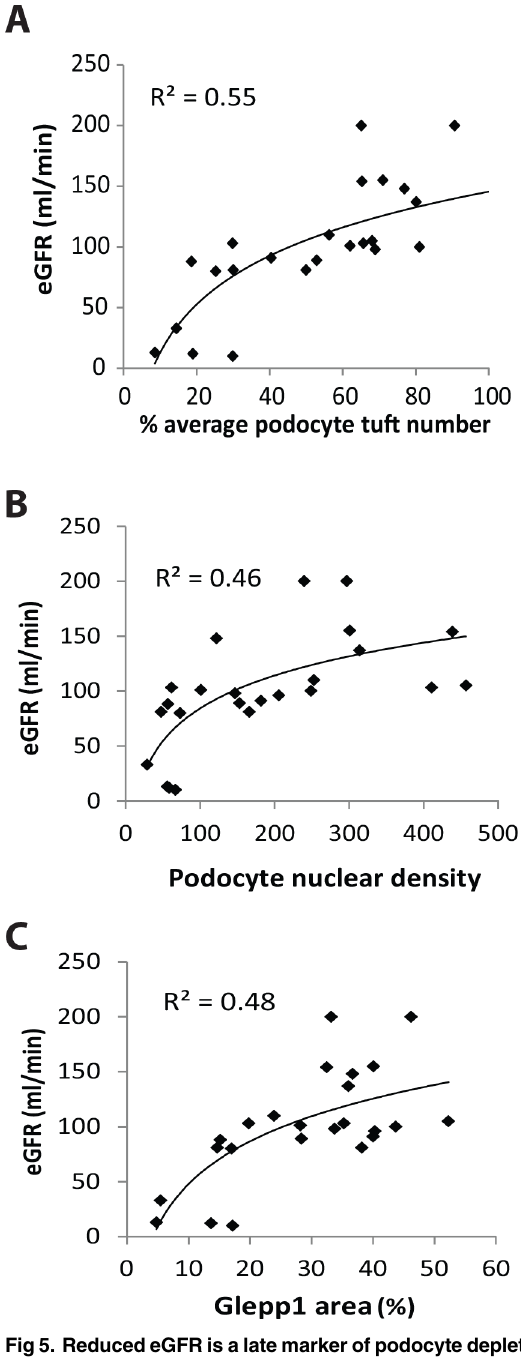
Fig 5. Reduced eGFR is a late marker of podocyte depletion. Panel A : Kidney function as measured by eGFR is detectably reduced only when podocyte depletion is reduced to the level of about 20% of normal (i.e. 80% depletion). Panel B: eGFR becomes measurably reduced when podocyte density falls below 100 per 10 6 um 3 . Panel C: eGFR becomes measurably reduced when the Glepp1% area is reduced below about 15 – 20%. Two eGFR values of 380 and 400 ml/min from an infant aged 2 and 3 years with a serum creatinine of 0.1mg% and high level proteinuria at the time of biopsy were excluded from analysis because of the inherent inaccuracy of the eGFR estimate under those conditions. These data collectively show that reduction in eGFR below the normal range (60ml/min) is a late marker of podocyte depletion in ASC biopsies. Logarithmic equations using best fit curve estimation are used in all